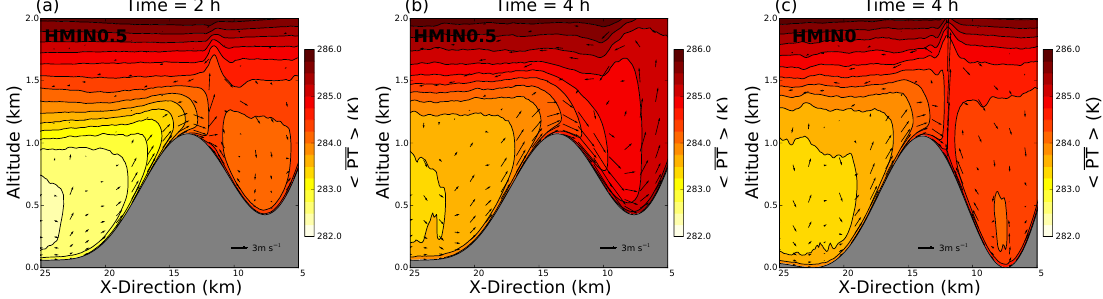
Figure 5. Cross sections of averaged potential temperature as contour lines (increments of 0 . 25K) after (a) 2h and (b) 4h of simulation for the HMIN0.5 mountain shape and (c) after 4h for the reference run (HMIN0). Wind vectors for components parallel to the cross section. Variables are averaged in time and space (along y